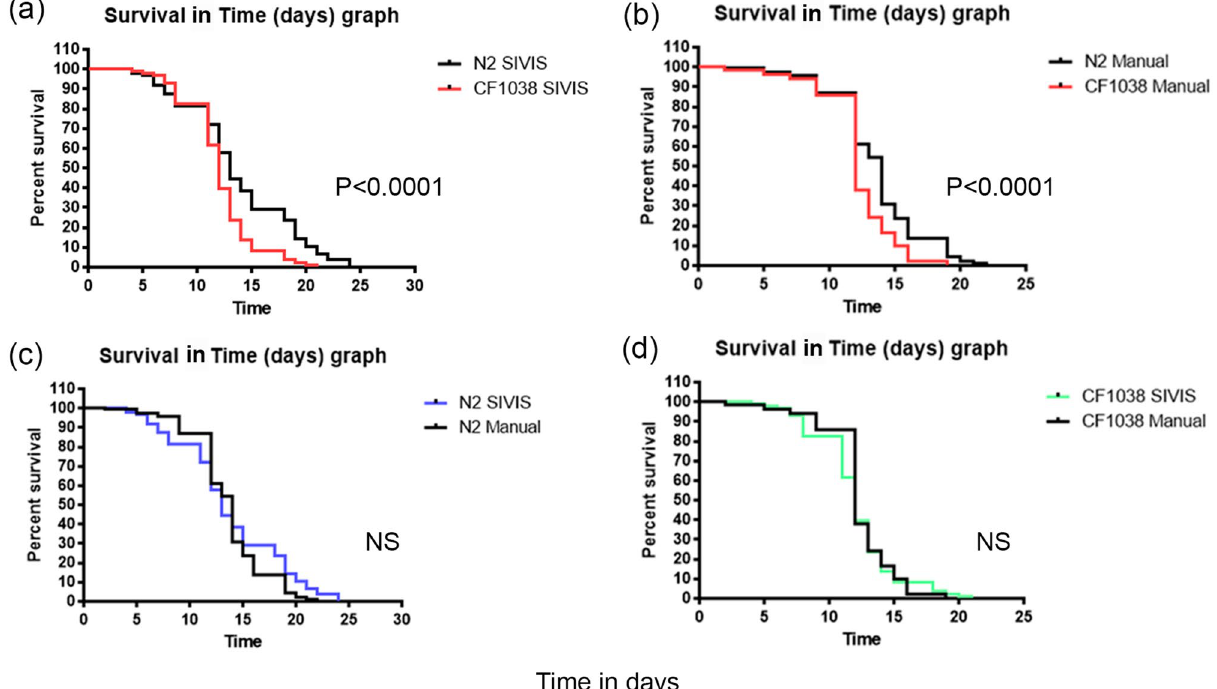
Figure 6. Lifespan of short-lived strain CF1038, daf-16 (mu86) . The graph was obtained with GraphPad Prism v. 4. ( a ) and ( b ) show the comparison between survival curves for CF1038 and the wild-type strain N2 in assays performed in SIVIS and manually, respectively. ( c ) and ( d ) show the comparison between the manual and automated system SIVIS for each strain. Data from three independent assays for automated assays ( n = 300 and 24 plates/condition) and two for manual assays ( n = 200 and 16